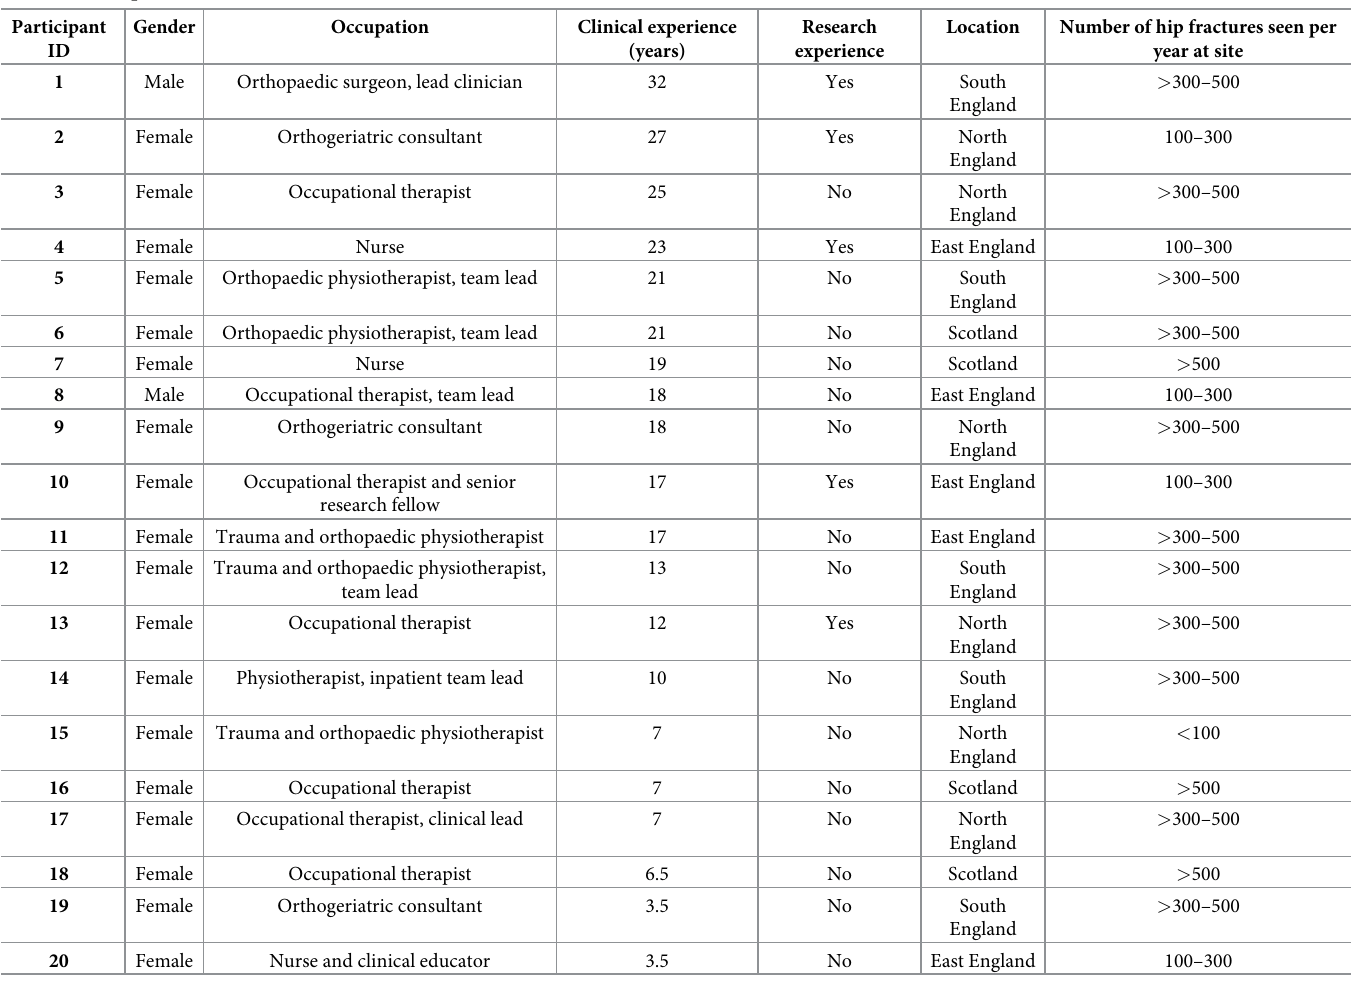
Table 1. Participant characteristics.